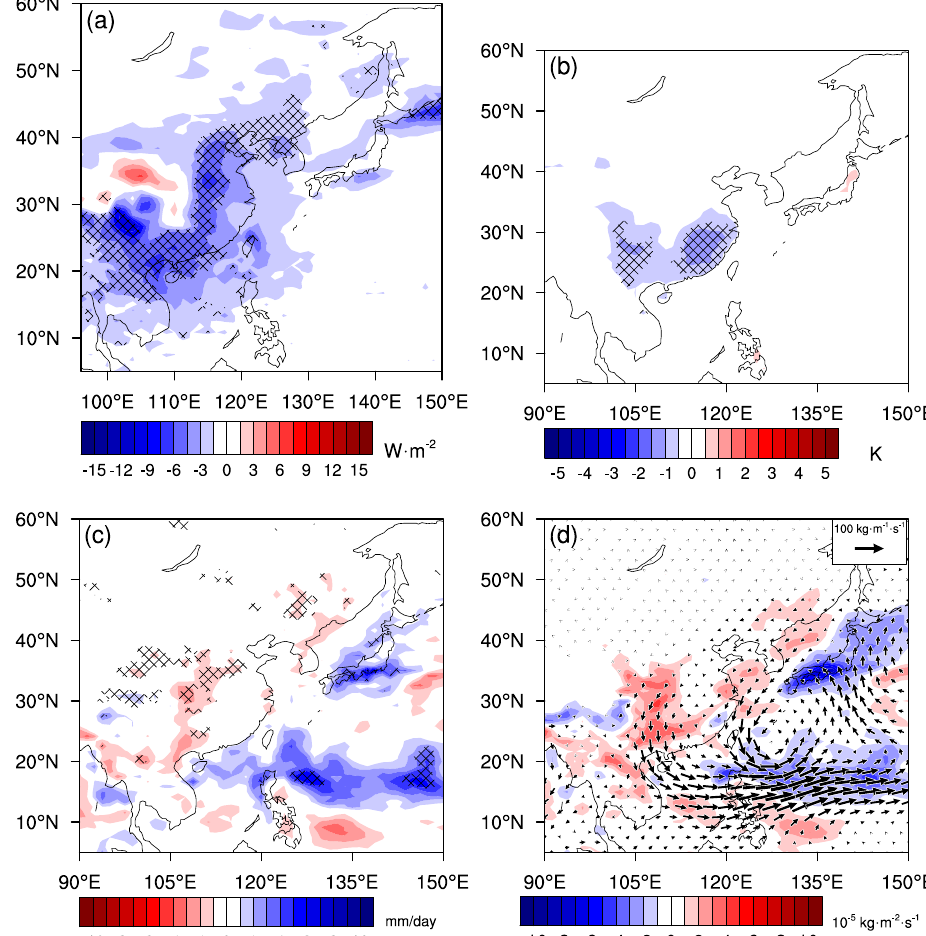
Fig. 10. (a) Eighteen-year mean net radiative flux (downward is positive) in September due to BC combined effect (Control minus BC 1950). Units: Wm − 2 . The blue box indicates East Asia (20–45 ◦ N, 100–122 ◦ E), the area mean value is shown above the to-right conner of the blue box. (b) Eighteen-year mean change in surface temperature in September for BC experiment. Units: K. (c) Eighteen-year mean change in precipitation in September for BC experiment. Units: mm/day. (d) Eighteen-year mean change in vertical integrated (surface to 700hPa) moisture flux (vector, units: kgm − 1 s − 1 ) and moisture flux divergence (shaded, units: kgm − 2 s − 1 ) for BC experiment. Significant changes excess 95% confident level are hatched. 35